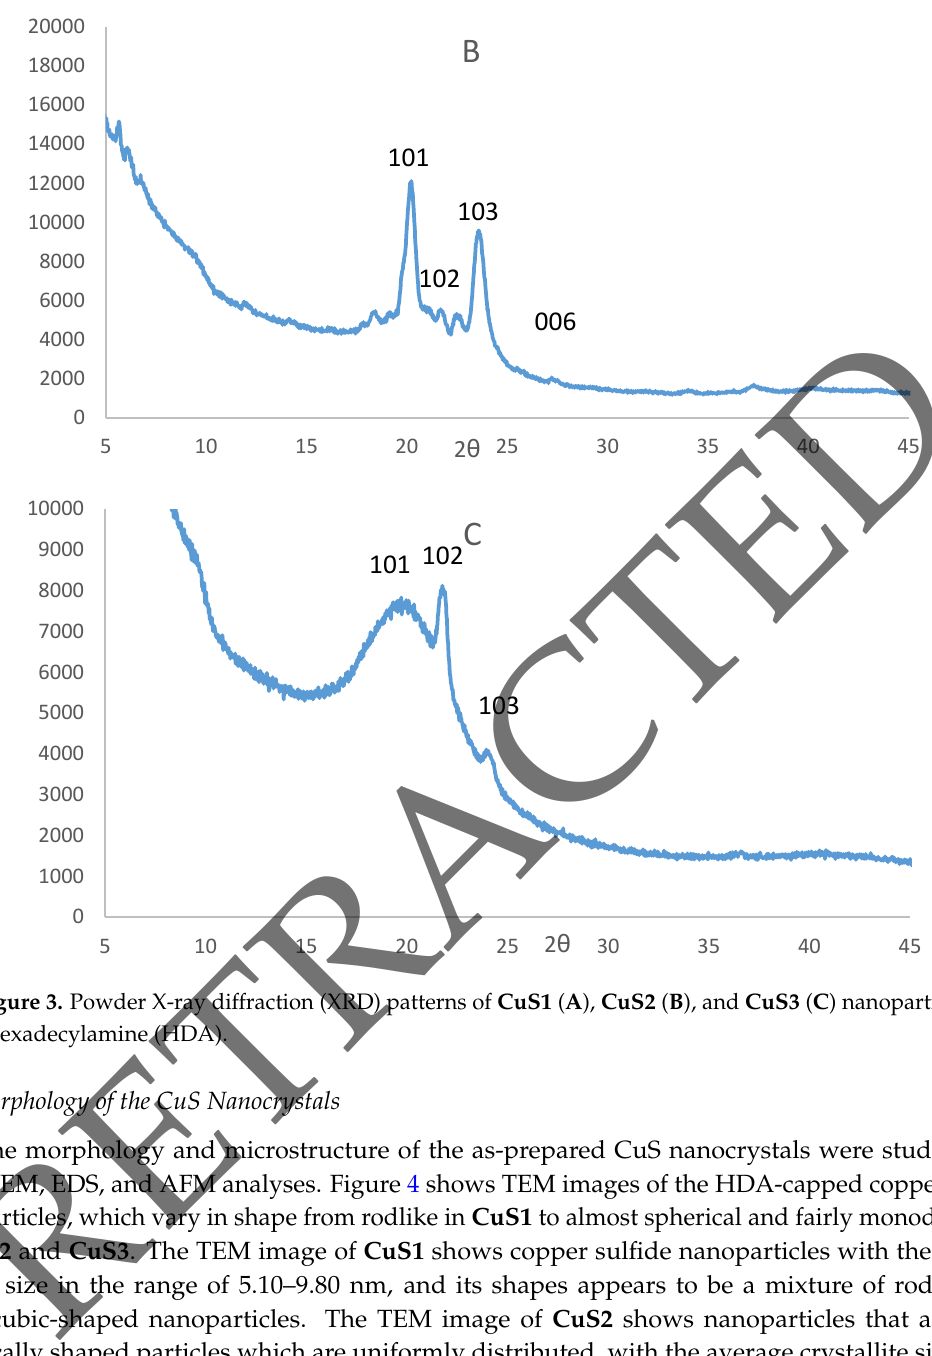
Figure 3. Powder X-ray diffraction (XRD) patterns of CuS1 ( A ), CuS2 ( B ), and CuS3 ( C ) nanoparticles * hexadecylamine (HDA).